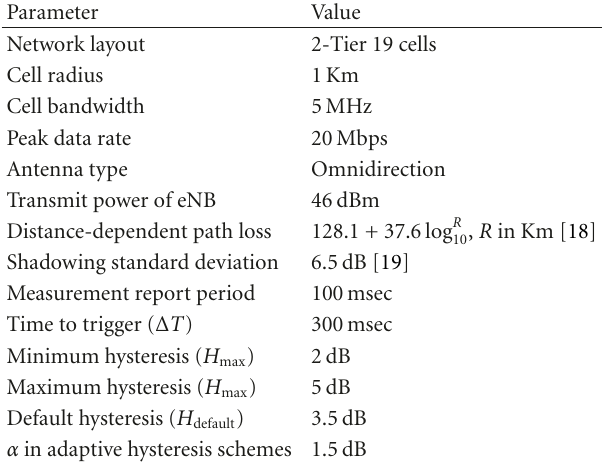
Table 2: Simulation